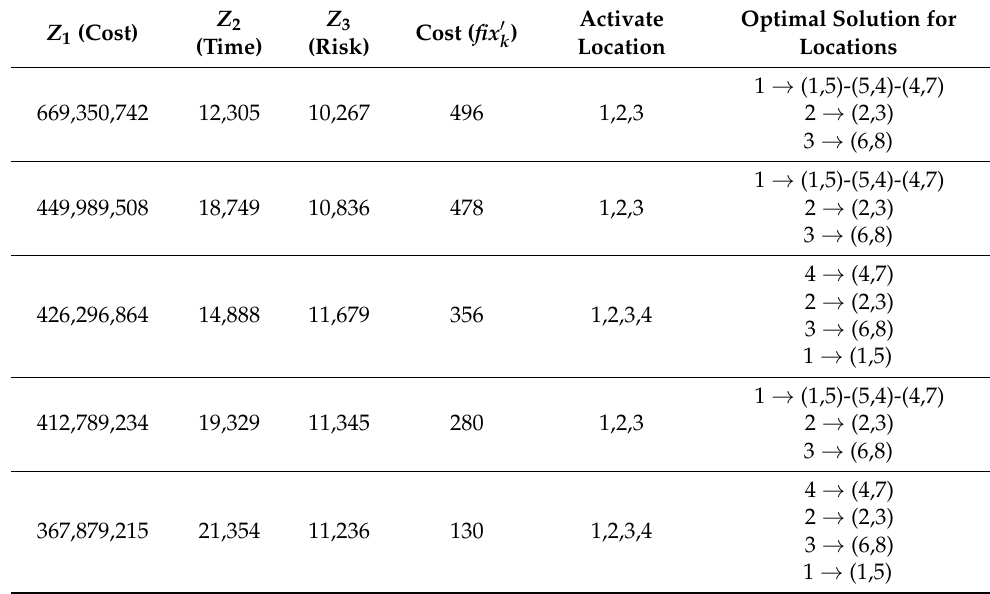
Table 11. Sensitive analysis of goals